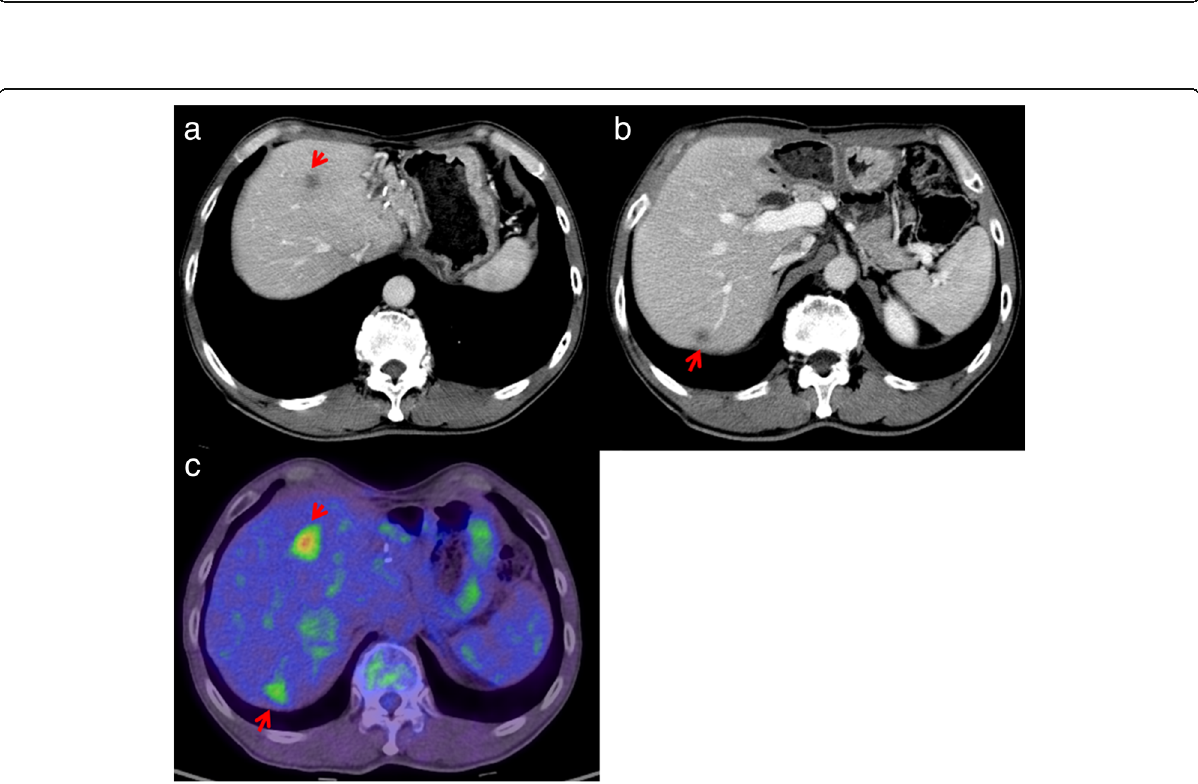
Fig. 3 CT scan shows hypovascularization in hepatic S4/S8 ( a ) and S7 ( b ). c On PET-CT, abnormal FDG uptake is observed in both hepatic tumors